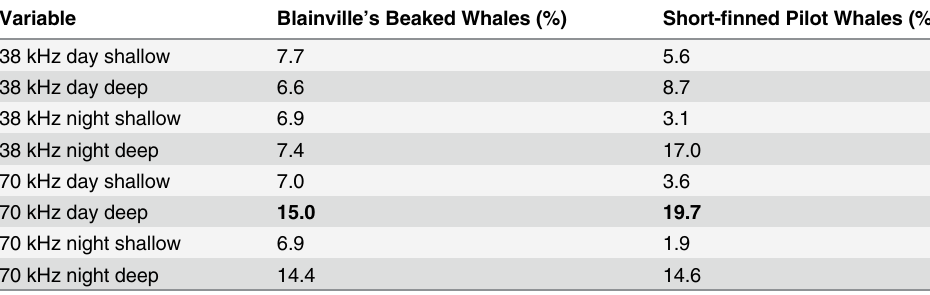
Table 5. Deviance explained by the biomass of each micronekton component in a single-variable GAMM for Blainville ’ s beaked whales and short-finned pilot whales.